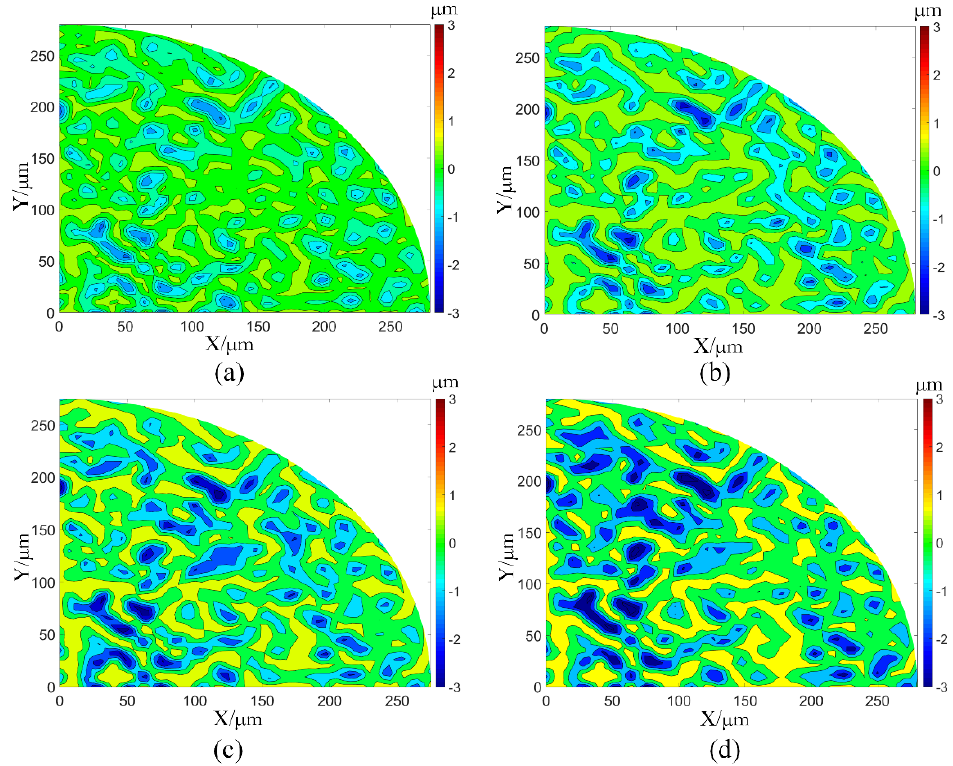
Figure 9. Surface morphology of specimens after deformation for different grain sizes; ( a ) d = 30 μm;